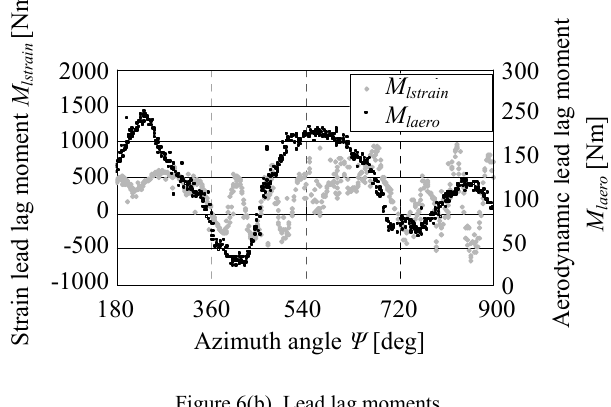
Figure 6(b). Lead lag